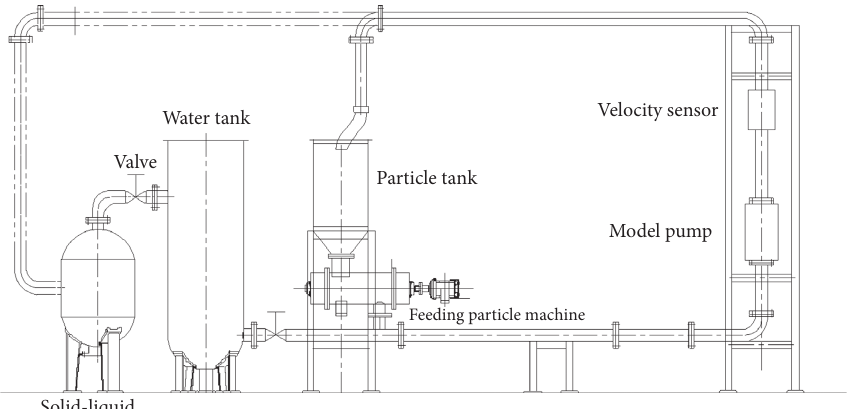
Figure 19: Schematic diagram of the slurry model pump test